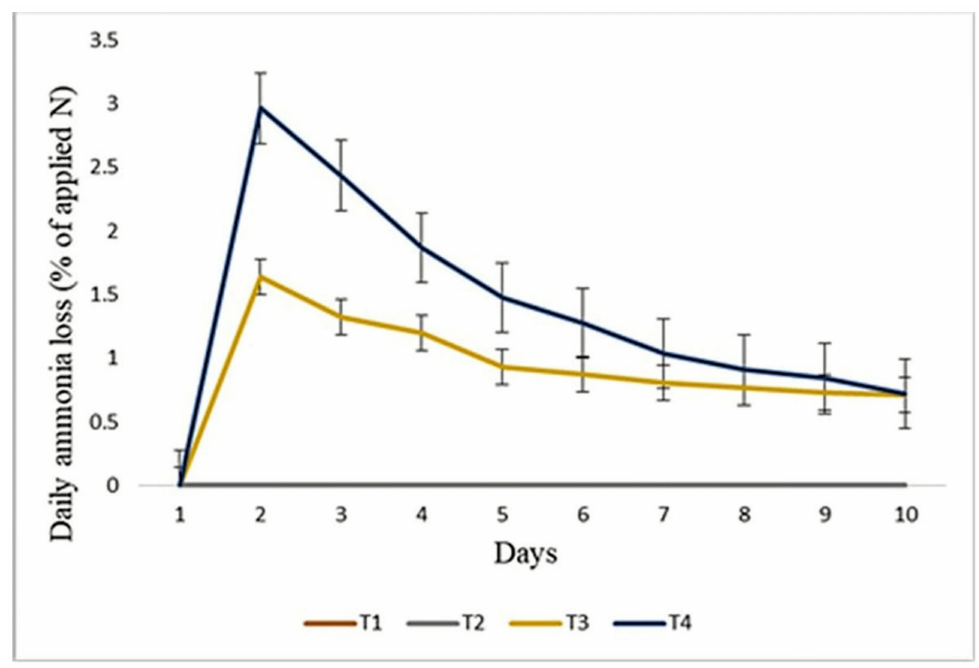
Figure 10. Daily loss of ammonia for 10 days of incubation. T1: Soil only, T2: F-NT, T3: BF-NT, T4: BF-T.